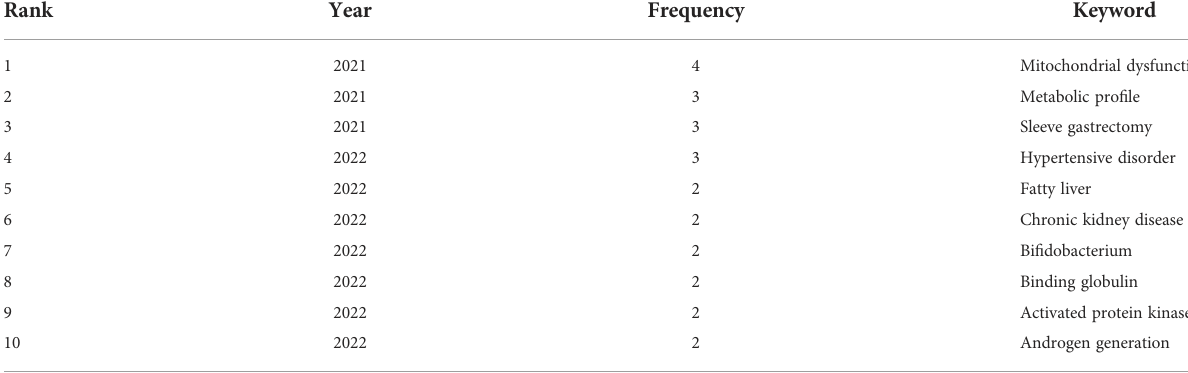
TABLE 6 Analysis of keywords from 2021 to 2022.